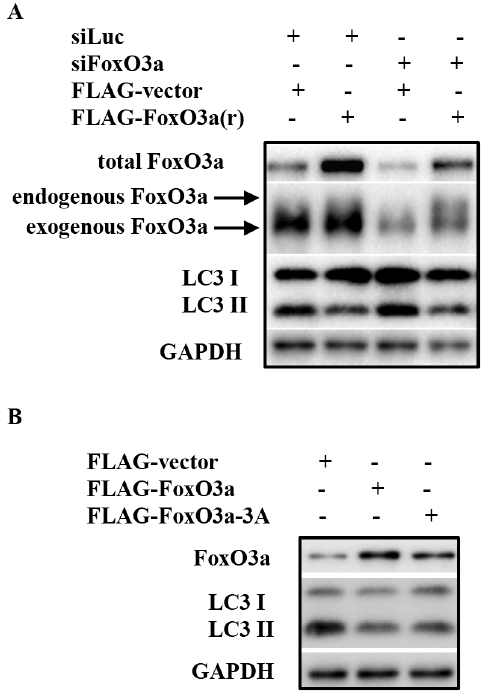
Fig. 3. FoxO3a over expression inhibits autophagy. (A) PC3 cells were transfected with either control siRNA or that targeting FoxO3a; each group of cells was also co-transfected with either ectopic expression vector control or that express FoxO3a(r). The cell lysates were harvested for immunoblot 72 h post transfection. (B) PC3 cells were transfected with 3 different expression plasmids, which are vector-Flag control, Flag-FoxO3a or Flag-FoxO3a-3A, respectively; the cell lysates were prepared 72 h post transfection for immunoblot analysis of the indicated proteins.